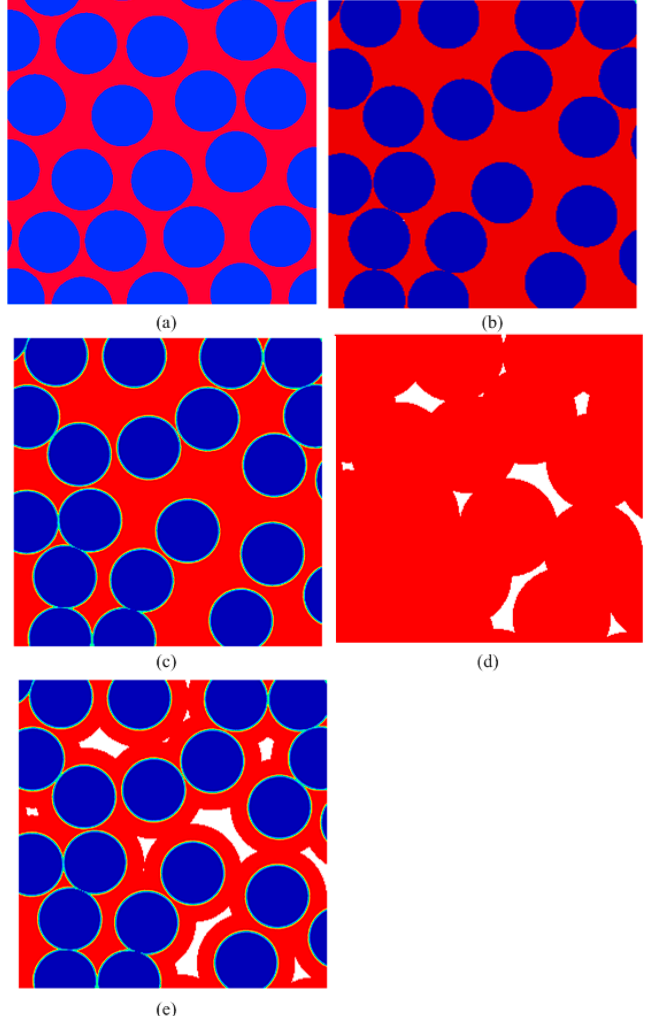
Figure 2. Illustration of the geometric models for unidirectional fiber structures: ( a ) The material systems composed of fiber and matrix with d min = 0.1; The material systems with d min = 0; ( b ) fiber and matrix; ( c ) fiber, interface and matrix; ( d ) matrix and pore; ( e ) all constituents.